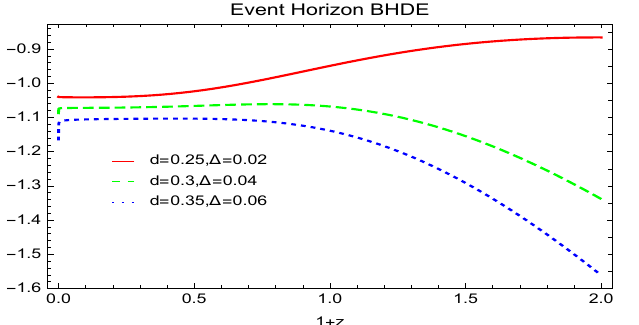
Figure 3. The EoS parameter ω ϑ versus redshift parameter 1 + z for interaction BHDE model with Hubble horizon for GDP braneworld cosmology.